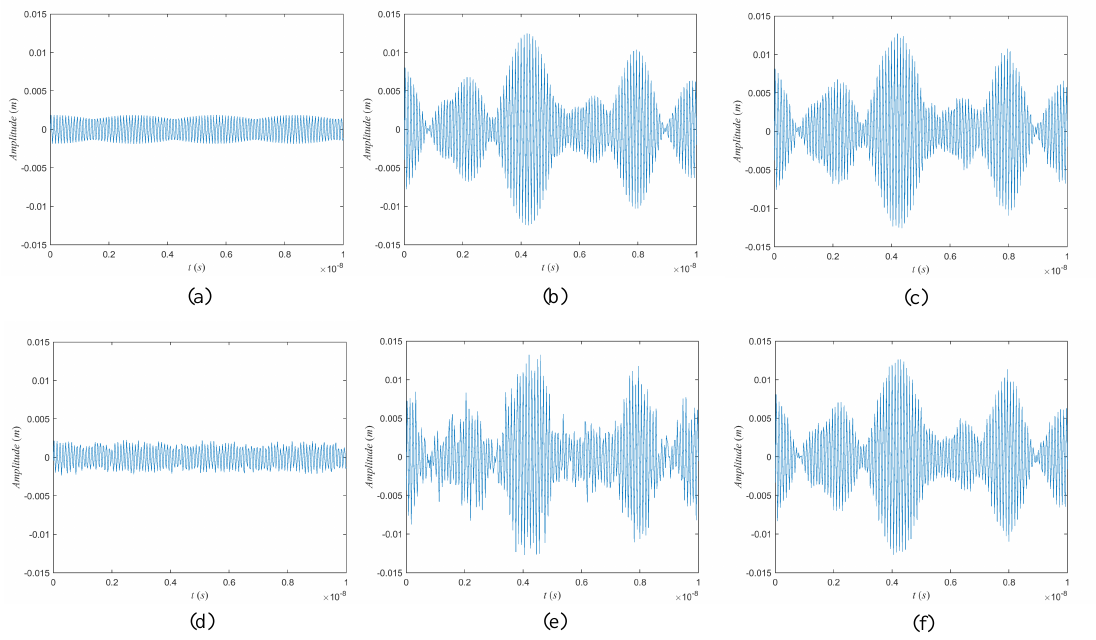
Figure 6. Echo signals in conventional MSCI and TD-MSCI. ( a ) is the echo of single transmitter under noise free condition. ( b ) is the echo signal of multiple transmitters under noise free condition. ( c ) is the echo signal in conventional MSCI under fixed noise level. ( d ) is the echo signal of time-division single transmitter with the frequency involed in ( a ) under the same noise level. ( e ) is the directly synthesized echo without echo enhancement. ( f ) is the synthesized scattering echo with 16 times coherent